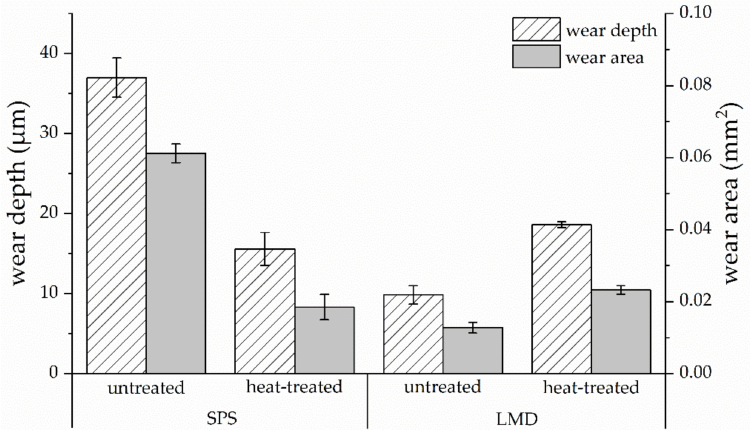
Figure 5. Ball-on-disk test of the untreated and heat-treated SPS bulk material and LMD coating of Al 0.3 CoCrFeNiNb 0.5 . The untreated LMD coating showed the highest sliding wear resistance. By heat treating the SPS bulk material, improvement in wear resistance was realized.